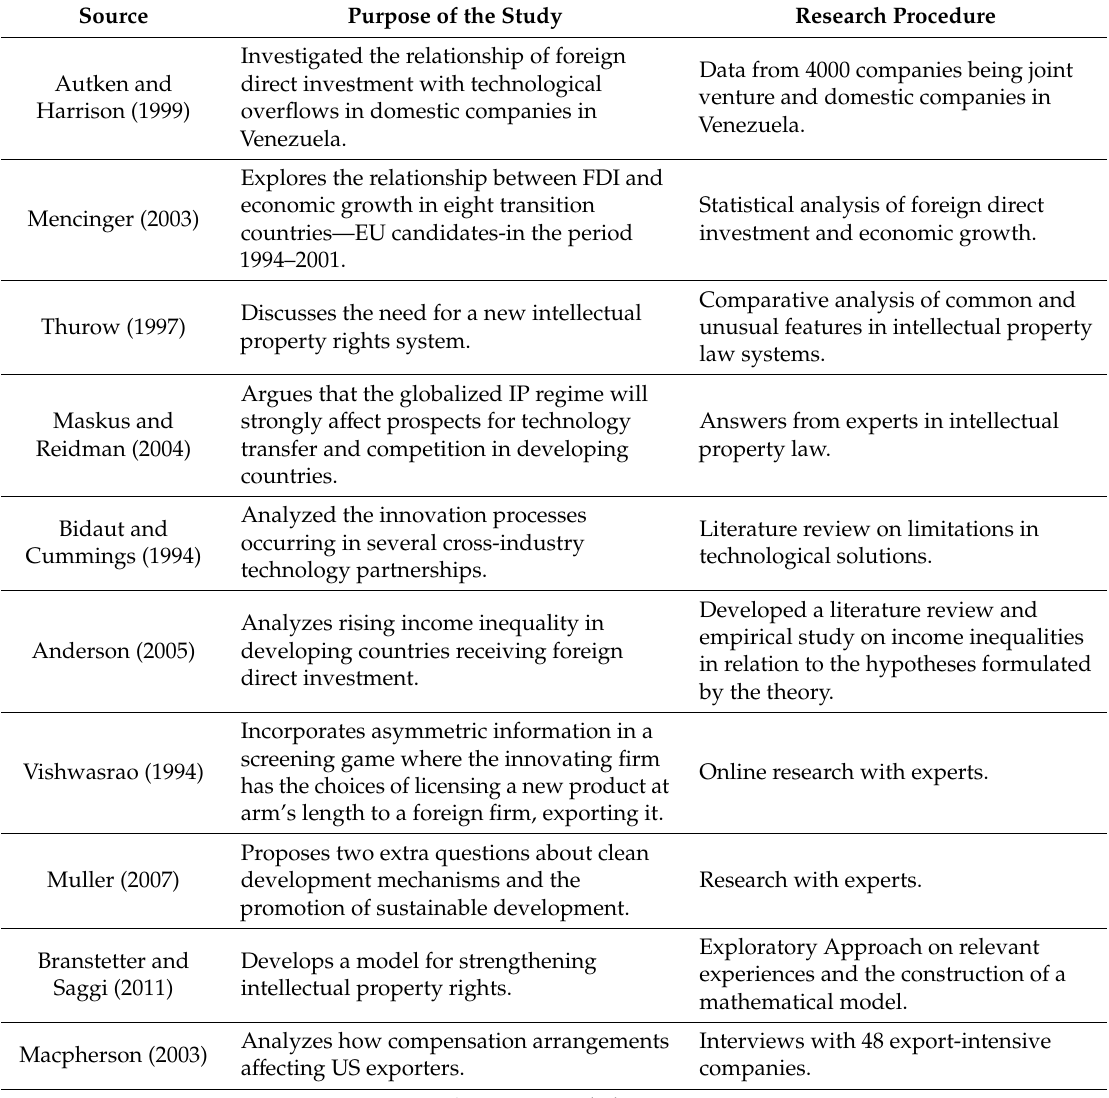
Table 4. Main studies